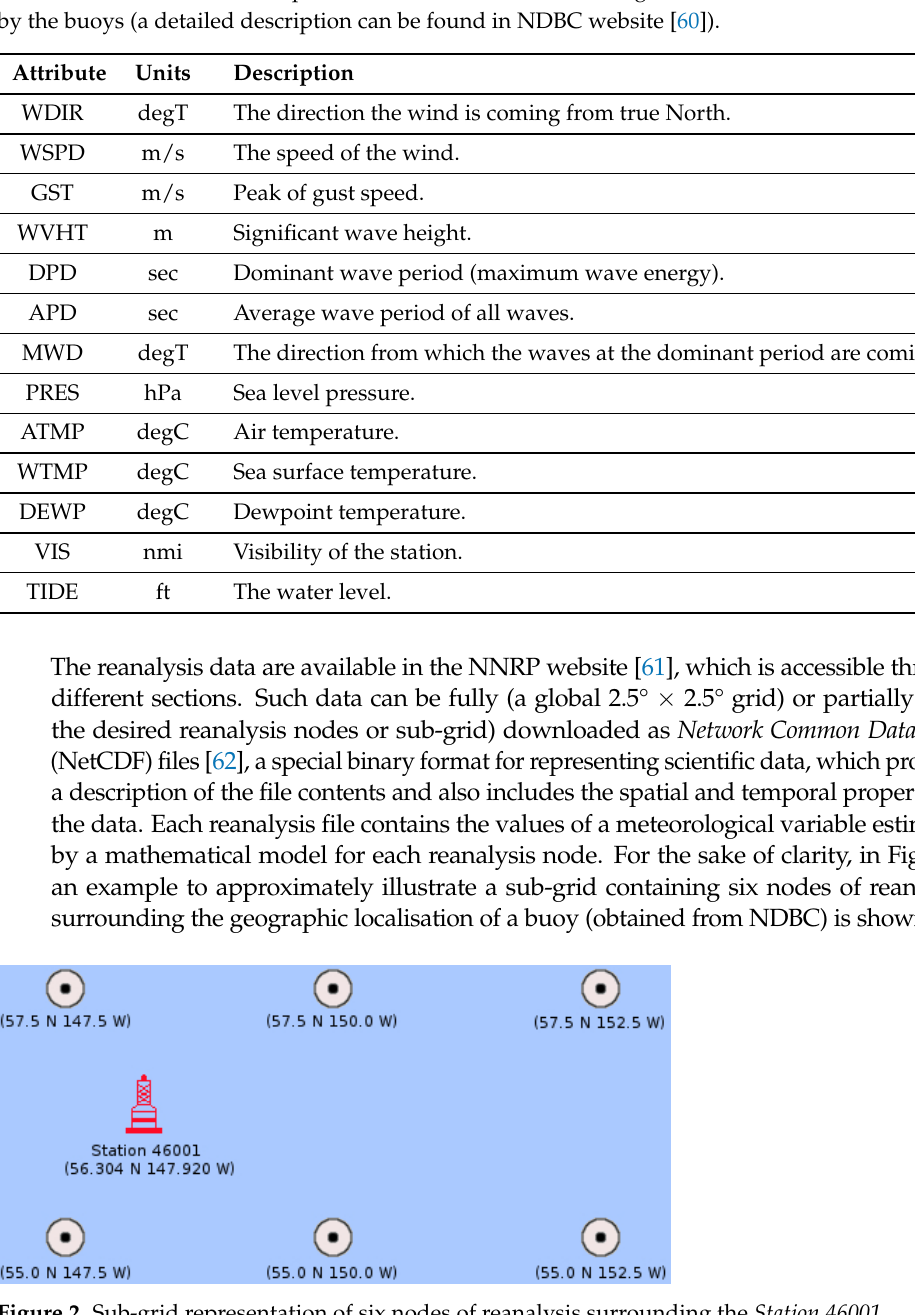
Figure 2. Sub-grid representation of six nodes of reanalysis surrounding the Station 46001